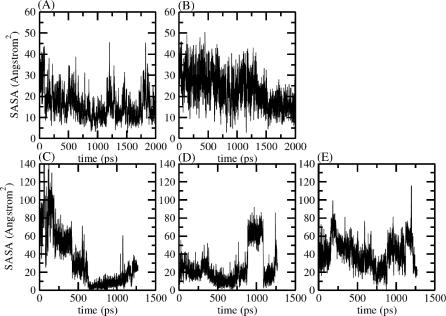
Solvent-Accessible Surface Area for Trp501 in Equilibrium and TMD SimulationsThe Lee-Richards–type SASA [77] for Trp501 in the equilibrium simulations 1FMW (A) and 1VOM (B) and in the three TMD simulations (C–E). A water probe with radius 1.4 Å and the Nina-Roux set of atomic radii [74,75] are used. The GBSW model is used in both equilibrium and TMD simulations.